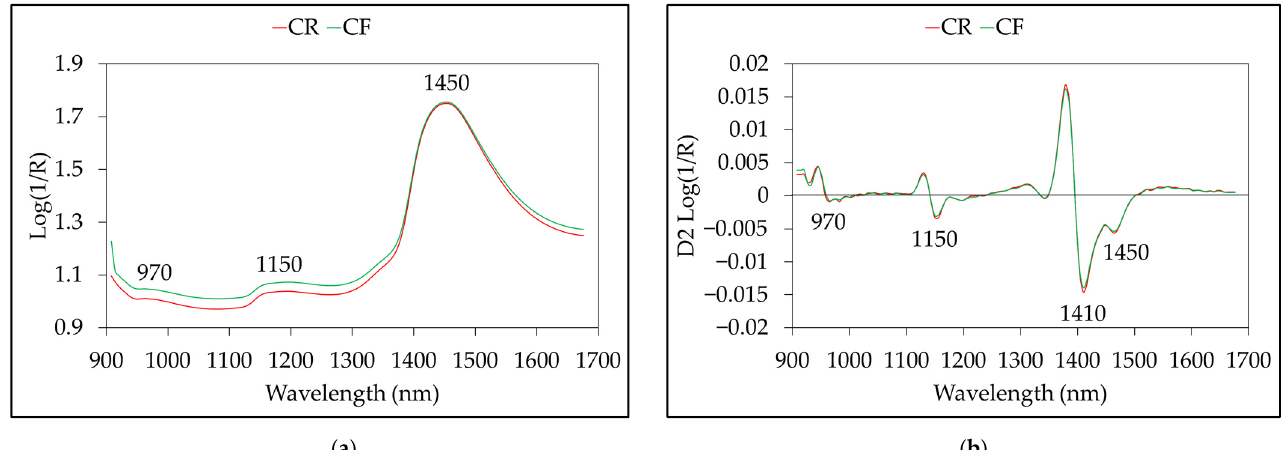
Figure 2. Average NIR spectra fromchlorpyrifos-free (CF) and chlorpyrifos residue (CR) groups: ( a ) raw spectra; ( b ) Savitzky–Golay second derivative spectra.